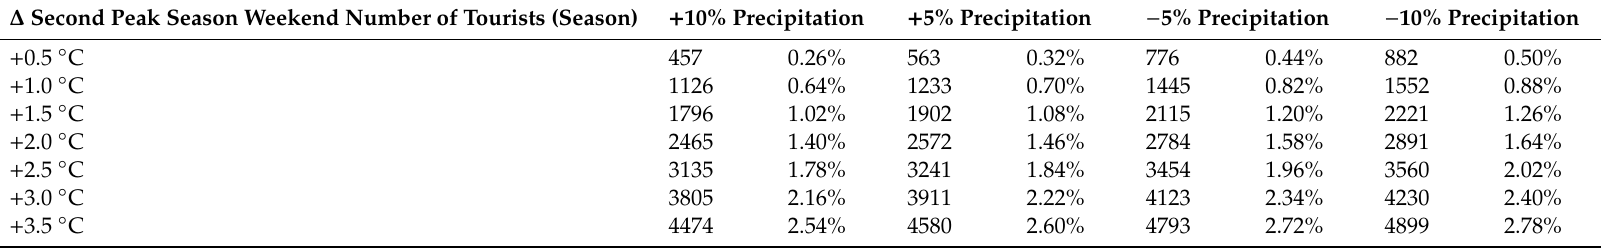
Table 11. Second peak season number of weekend tourists increase (persons per season) and increate rate (%). ∆ Second Peak Season Weekend Number of Tourists